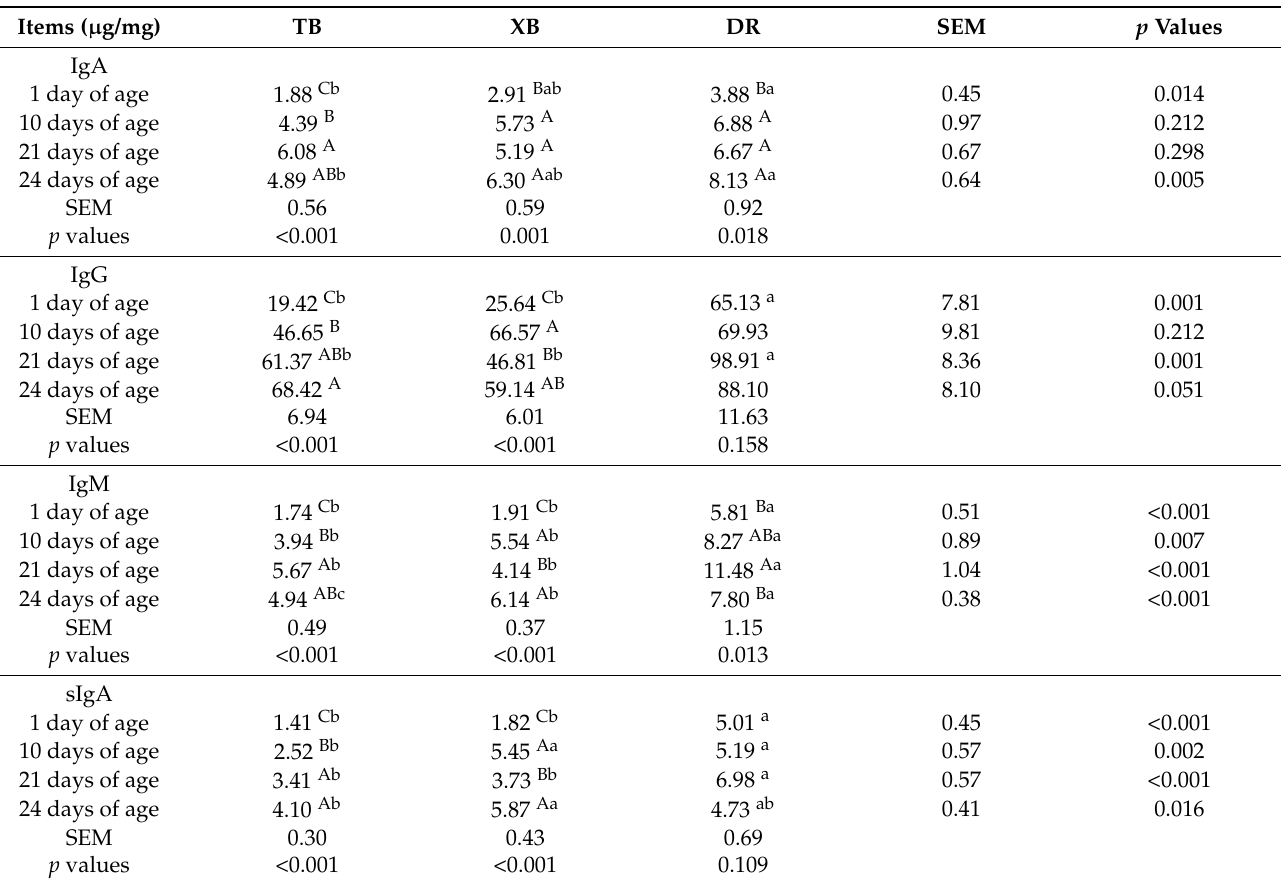
Table 3. Changes in ileal immunoglobulin levels of different pig breeds during suckling and weaning